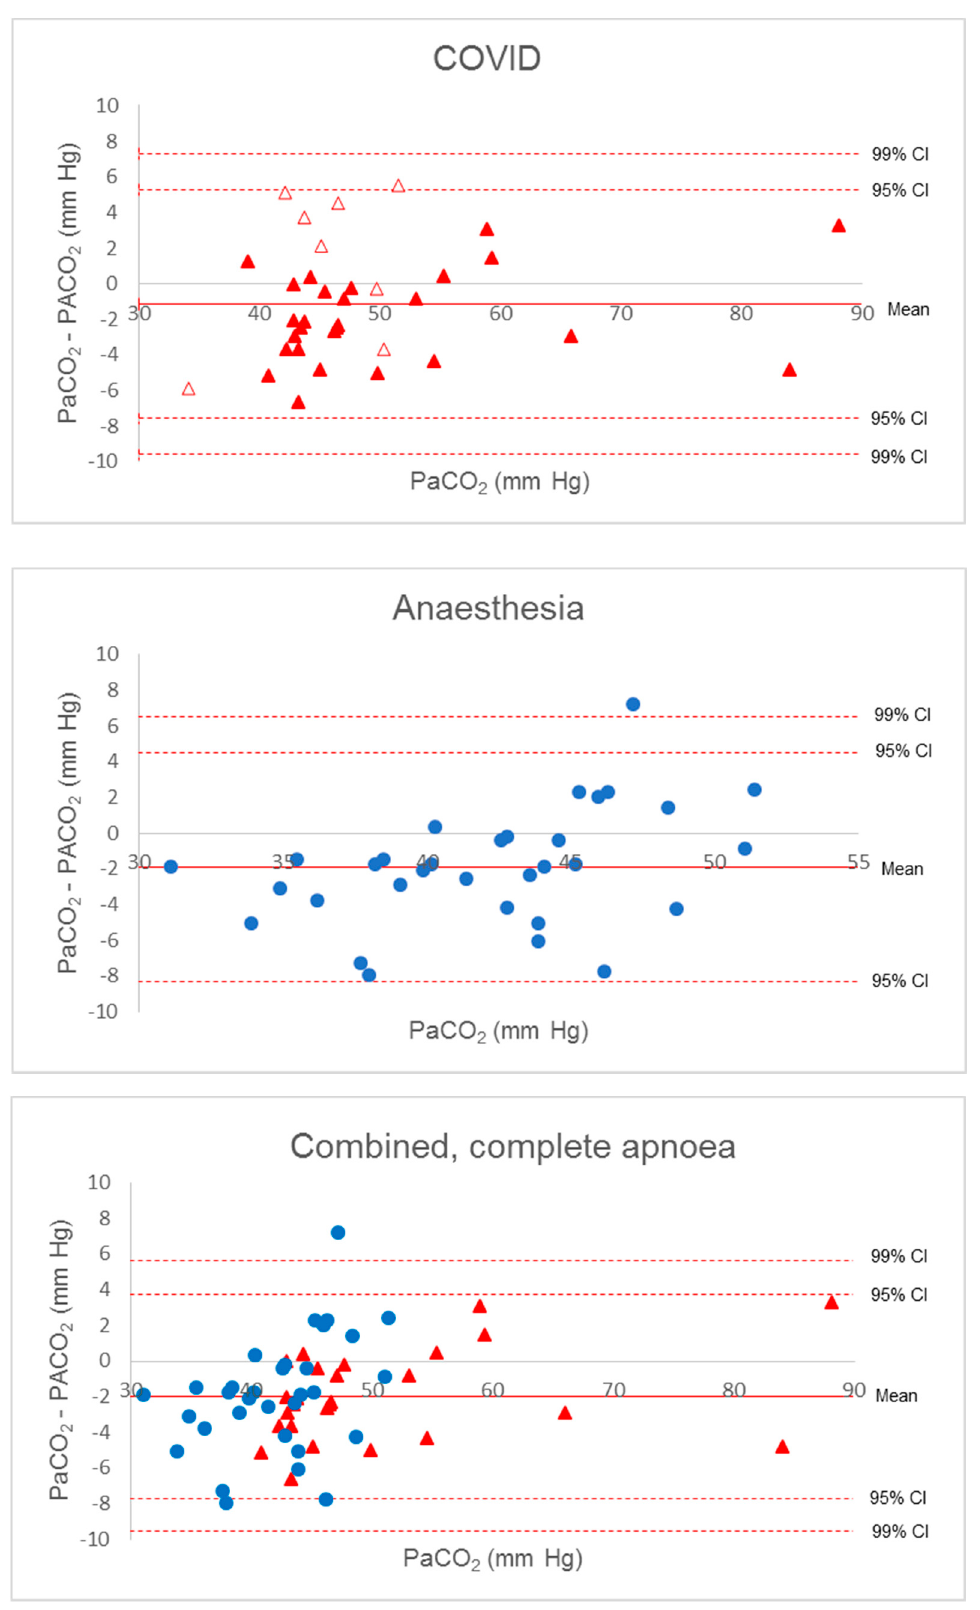
Figure 2. Bland–Altman diagram for P(a-A)CO 2 gradient. Solid red triangles, complete apnoea COVID patients; empty red triangles, incomplete apnoea COVID patient; blue circles, anaesthesia patients.